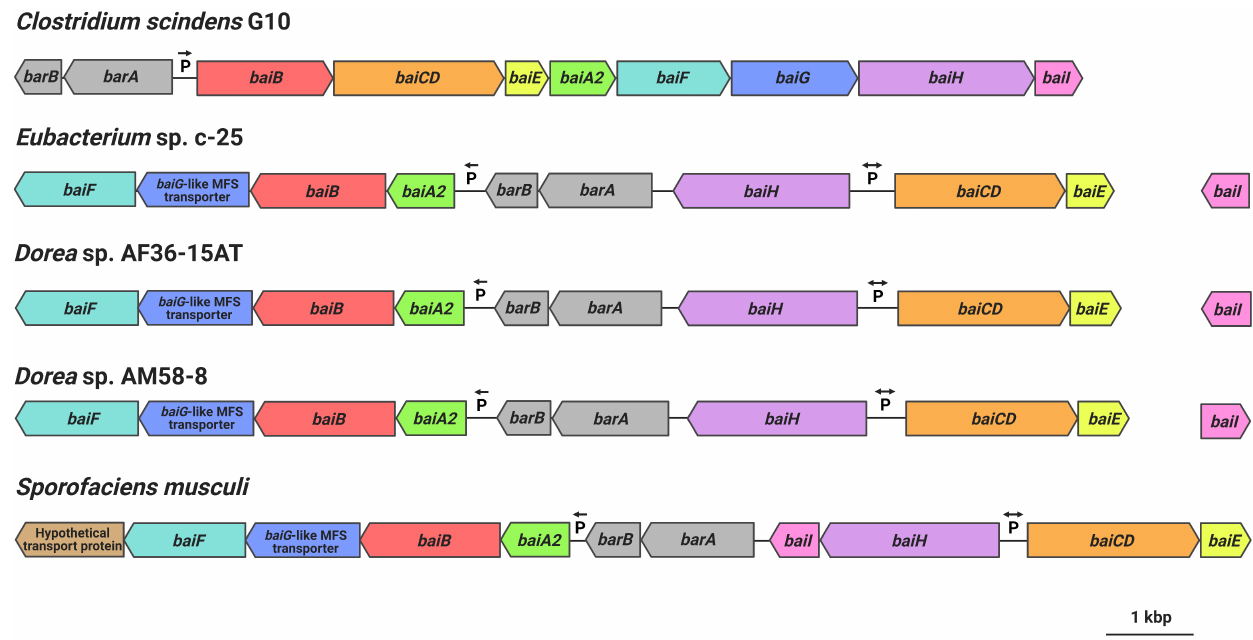
Figure 7. bai gene arrangements as observed in C. scindens G10, Eubacterium sp. c-25, Dorea sp. AF36-15AT, Dorea sp. AM58-8, and S. musculi . Shared genes (or predicted functional homologues in the case of baiG ) are color-coded. Figure created with